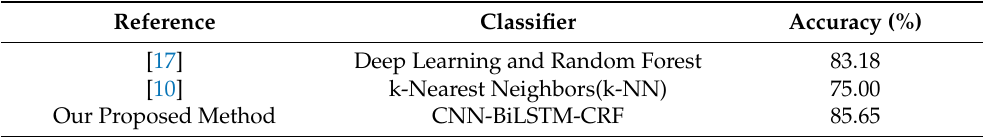
Table 7. Comparing our classification performance to previous EEG-based emotion recognition studies in financial